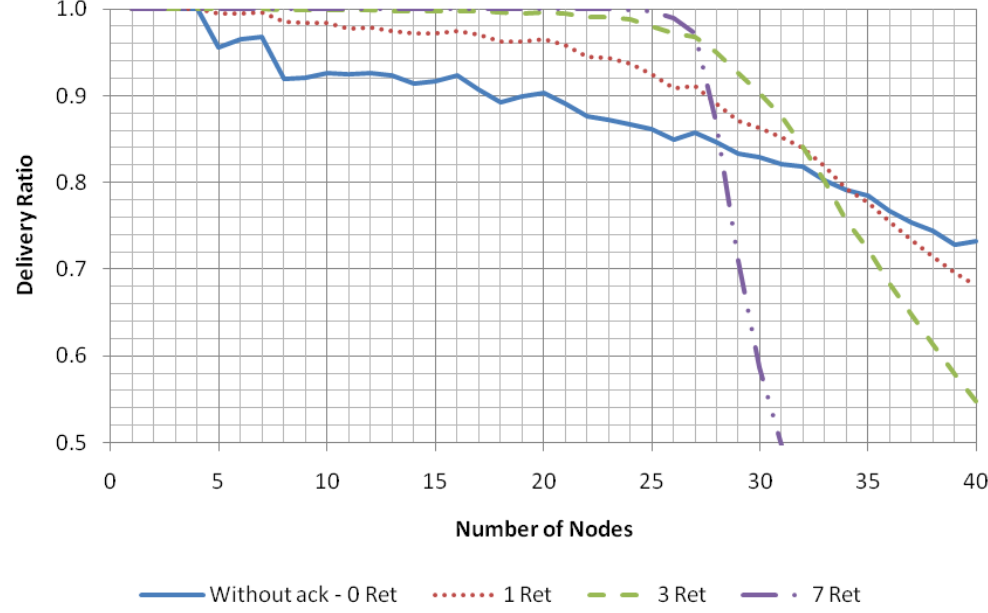
Figure 4. Delivery ratio for the unslotted CSMA/CA scheme with error-free channel.